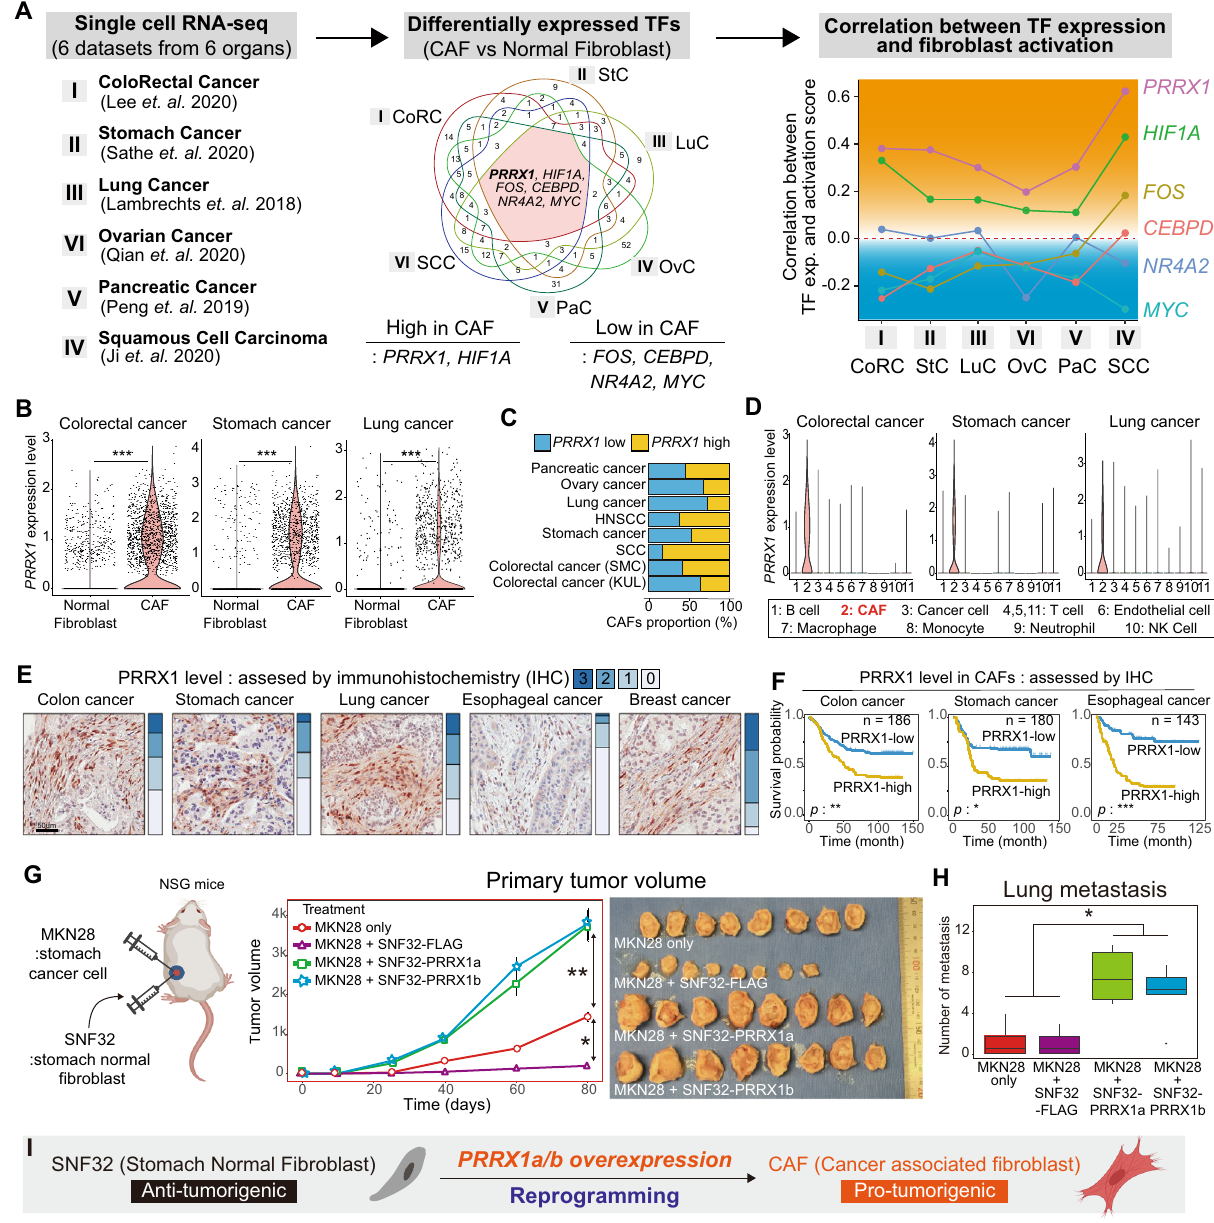
Fig. 1 Discovery of PRRX1 as a highly CAF-speci fi c TF with signi fi cant correlation with poor prognosis in diverse cancer types. A Schematic diagram showing the method used to identify activated CAF-speci fi c TFs in six cancer tissues compared with that in normal fi broblasts using large-scale single-cell RNA sequencing (scRNA-seq) datasets. PRRX1 was identi fi ed as a CAF-speci fi c TF and was highly correlated with the CAF activation score. B Level of PRRX1 expression in normal fi broblasts and CAFs in colorectal, stomach, and lung cancers (two-sided Wilcoxon rank-sum test, *** p < 2e − 16, Colorectal cancer n = 2047, Stomach cancer n = 1821, Lung cancer n = 2002). Others are shown in Supplementary Fig. 1B. C Bar plots of the proportion of CAFs with high-PRRX1 expression in the eight scRNA-seq datasets. The criteria used for categorizing high ( + )- and low ( − )-PRRX1 CAFs are shown in Supplementary Fig. 1C. D Analysis of eight scRNA-seq datasets revealed that PRRX1 expression is highly restricted to CAFs across 11 cell types (two-sided Wilcoxon rank- sum test, *** p < 2e − 16). Others are shown in Supplementary Fig. 2E. E Immunohistochemical analyses revealed that PRRX1 protein is speci fi cally detected in CAFs in all fi ve cancer types. Representative Images from fi ve FFPE tumor microarray sections (TMA). F Kaplan – Meier (KM) survival analyses using immunohistochemistry revealed that a high level of CAF-speci fi c PRRX1 expression is signi fi cantly associated with unfavorable overall survival in the colon, stomach, and esophageal cancers. p value was calculated using log-rank test: * p < 0.01, ** p < 0.001, *** p < 0.0001. G , H (i) Human stomach cancer cells (MKN28) alone, (ii) mixed with SNF32 (human stomach normal fi broblasts)-FLAG (control), or either (iii) Prrx1a- or (iv) Prrx1b-overexpressing SNF32 were co-injected subcutaneously into NSG mice. Measurement of primary tumor volume and H&E images of tumors in each group. G Data are presented as the mean ± SEM, n = 8 tumors per group, two tailed t test: * p < 0.005, ** p < 0.0001. H Box plot showing number of lung metastasis( n = 6 mice/group). p value was calculated using two tailed t test: * p < 0.05. Data are presented as box-and-whisker plots indicating median (middle line) and minimum and maximum values (whiskers). I Schematic summary of the results. Source data and exact p values are provided as a Source Data fi